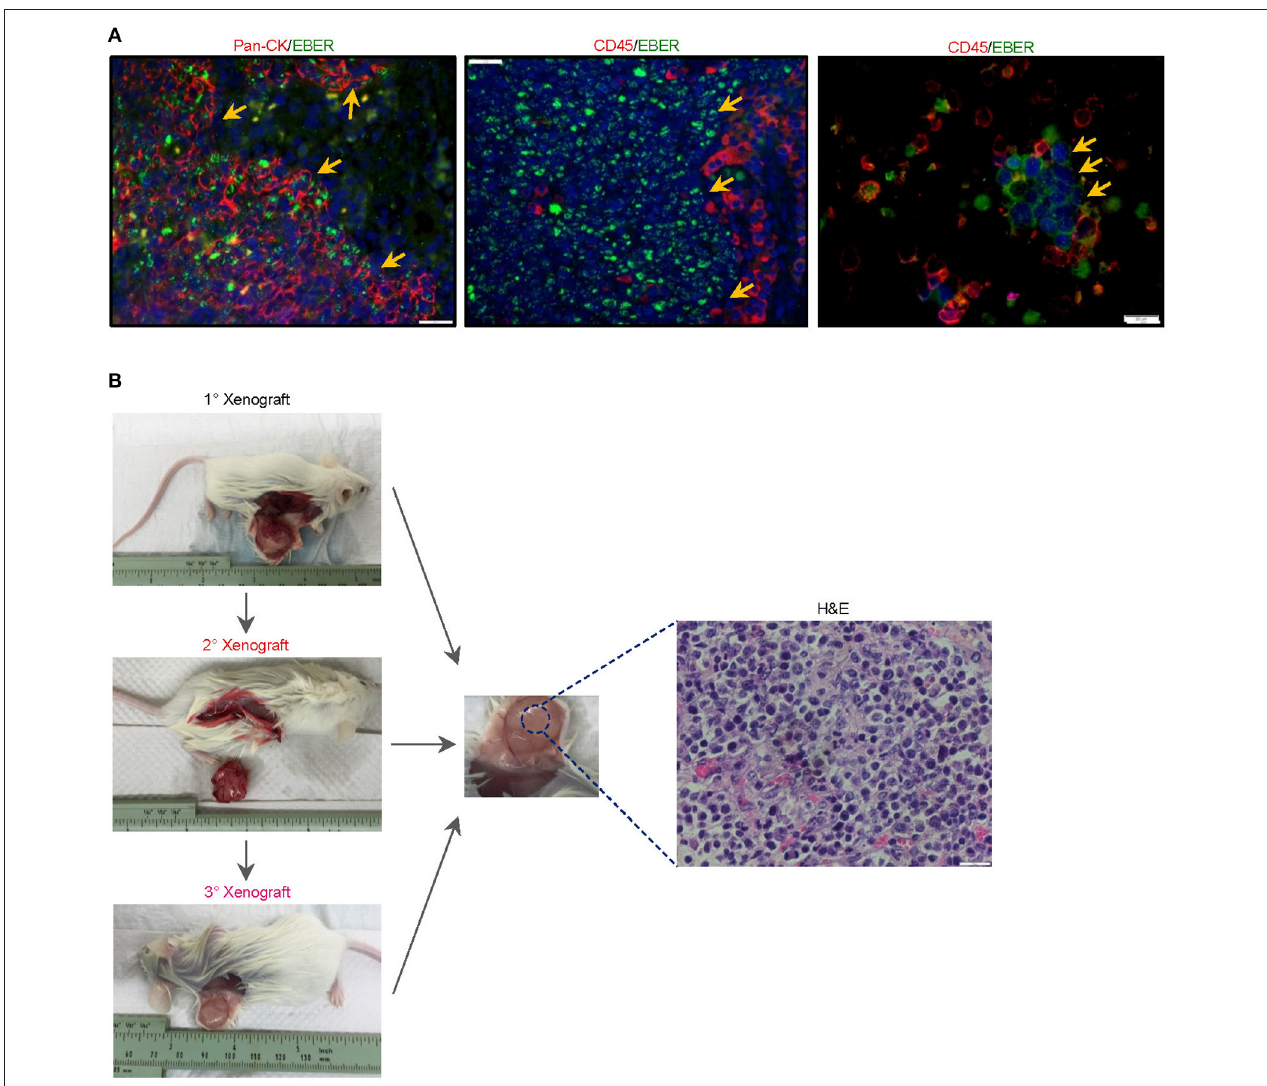
FIGURE 2 | Histological characterization of the newly-established cell line. (A) To investigate whether the serendipitous generation of a B-lymphoma xenograft derived from a pre-existing but innocuous and quiescent population of EBV-driven B-lymphoma cells, we re-examined 4- µ m sections of the original NPC biopsy and dissociated cells which were cytospin onto slides. EBER-ISH signals were exclusively detected on pan-cytokeratin cells and absent in CD45 + lymphocytes, suggesting that intratumoral B cells in the NPC biopsy were not likely to be infected with the virus. The cell nuclei were counterstained with DAPI (blue). (B) Yu103 cells were tumorigenic when injected into NSG mice subcutaneously. The xenografts were serially passageable in mice and retained identical histology and morphology as the parental